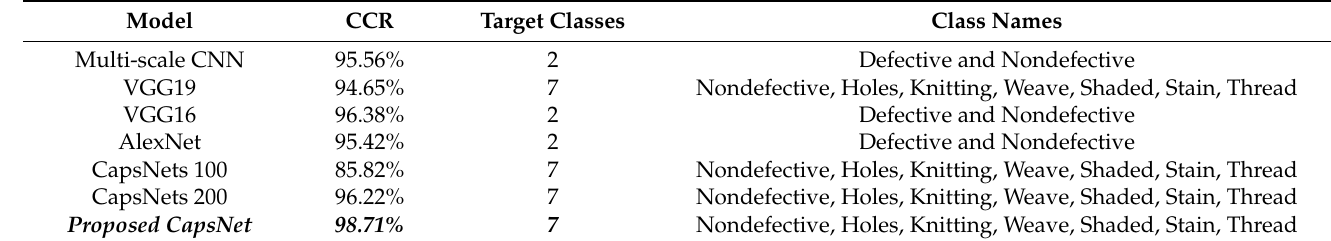
Table 4. Performance comparisons.